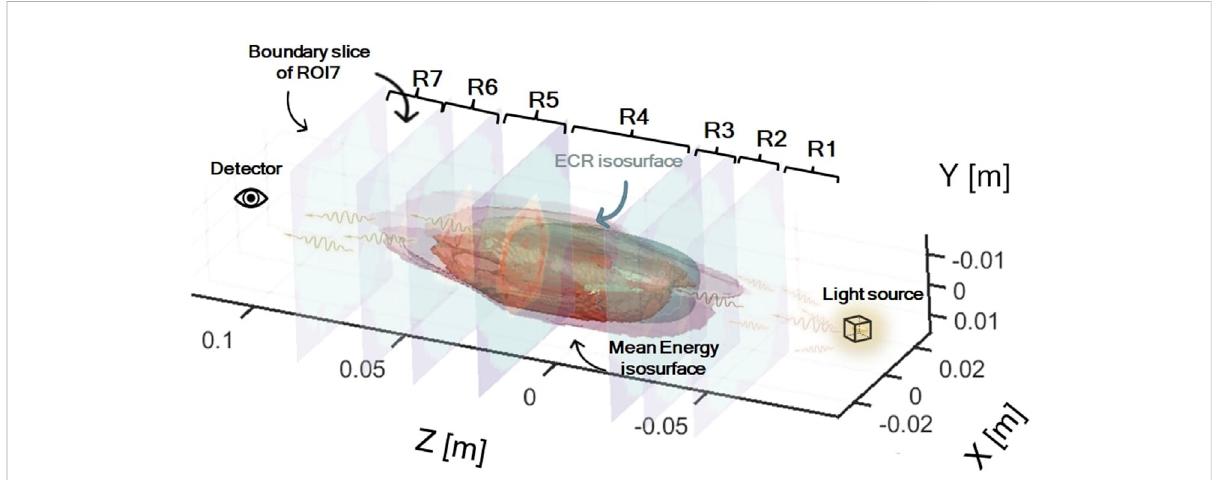
FIGURE 3 Representation of simulated plasma slicing along the longitudinal z -axis for studying the layered optical properties of Ar plasma. Nested isosurfaces refer to the volumetric collection of electron with the same mean energy content. Magnetic isosurface at the ECR (light-blue) is also shown. Along the z -axis regions of interest (R) have been selected and indicated in the fi gure, intersecting inhomogeneous plasma regions with different electron density ρ e and energy k B T e , both numerically extracted in the [0,2] keV energy interval, and associated to each R. All the R is assumed as homogeneous plasma slab to be studied in FLYCHK, in the presence or not of a light source black-body radiation fi